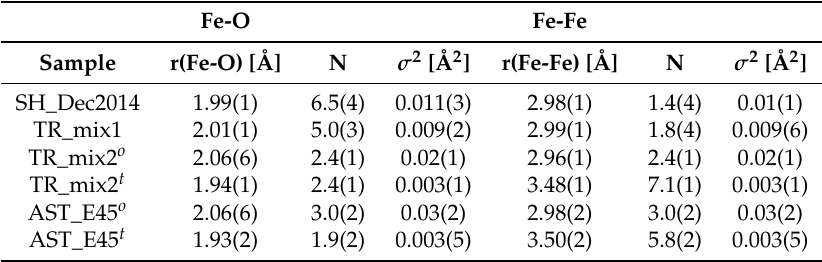
Table 3. EXAFS: quantitative data analysis results for Saharan dust (SH_Dec2014), Steel production emission (AST_E45) and mixed aerosol samples collected in the Terni urban area (TR_mix1 and TR_mix2). Errors in the last significant figure are indicated in